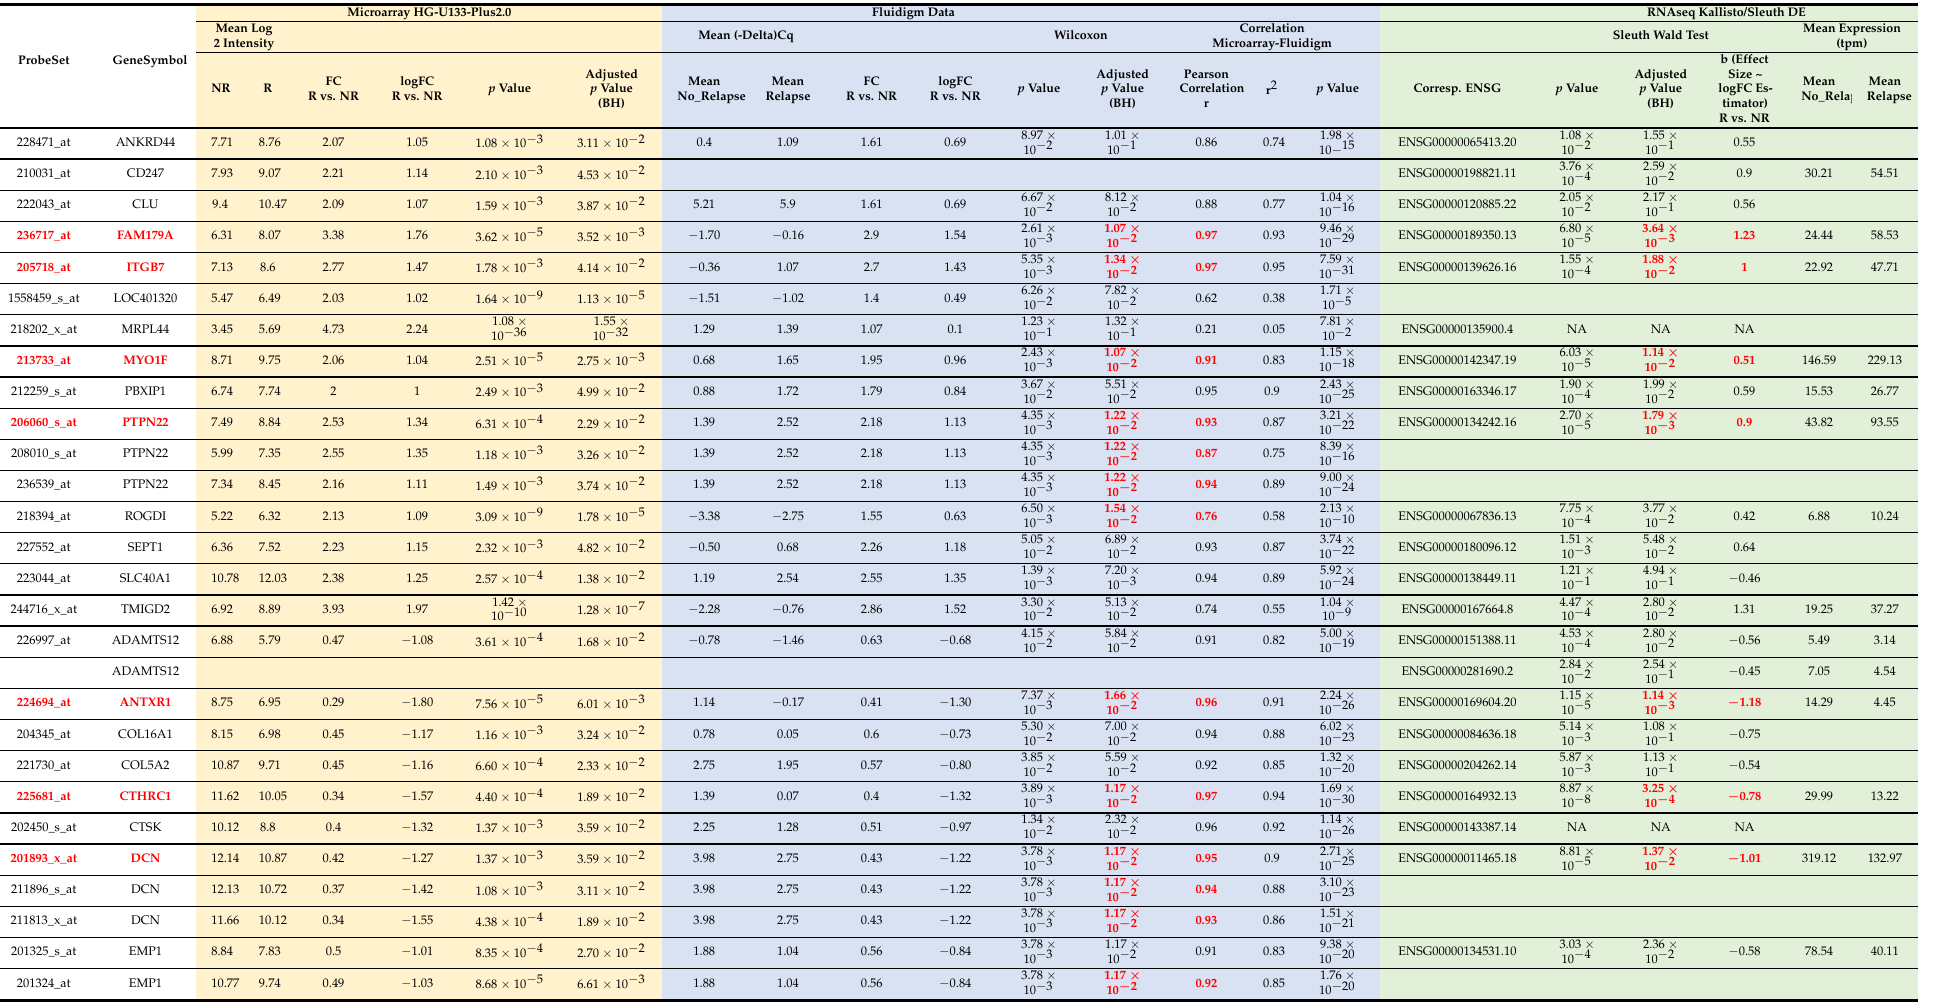
Table 2. Expression levels, fold change (FC), p -values, and rank of importance of the genes discriminating relapsing ALK + and non-relapsing ALK + tumors using microarray, high-throughput qPCR, and RNA sequencing